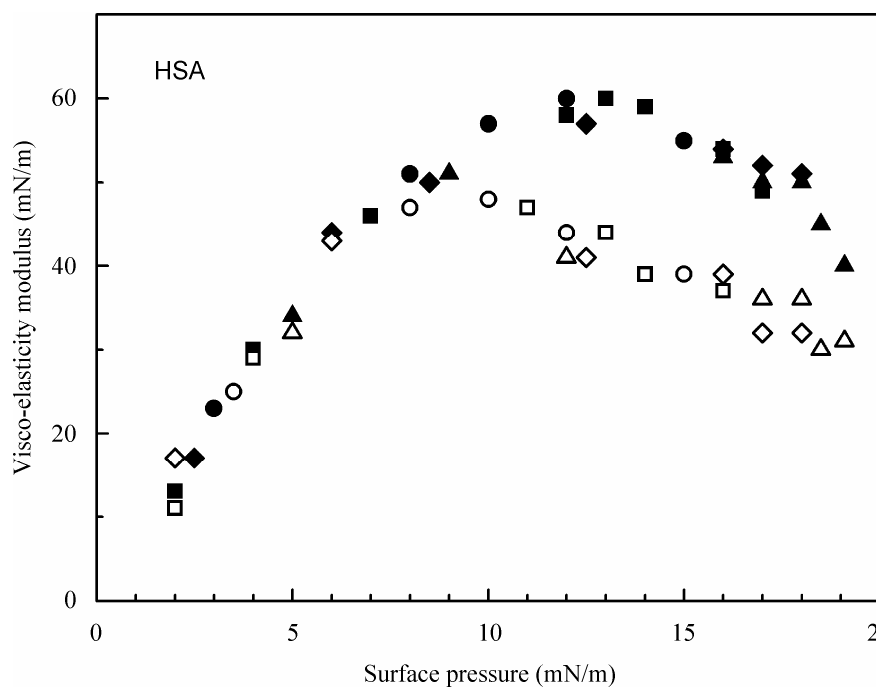
Figure 3. The same as in Figure 1 but for HSA solutions.